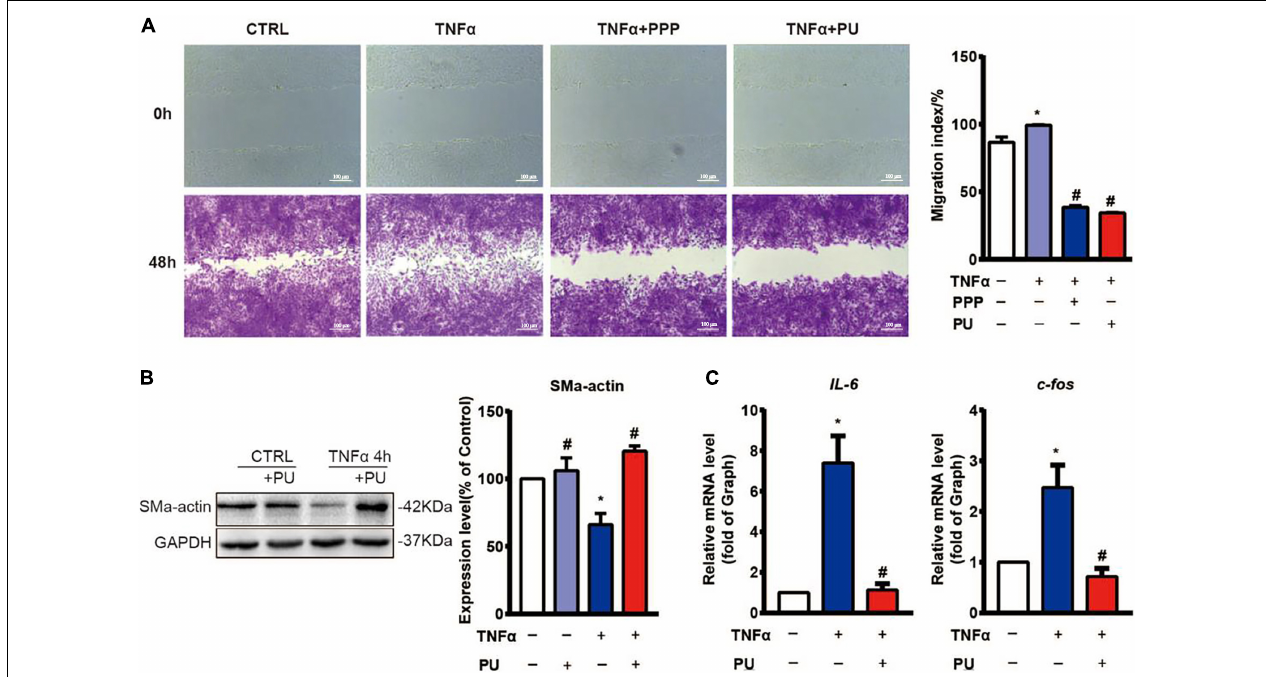
FIGURE 8 | PPP and PU inhibit migration, phenotypic modulation and inflammation in VSMCs induced by TNF- α . (A) The migration of VSMCs was detected by wound-healing assay (three independent experiments performed). (B) Western blot analysis and quantitative results of the effects of PU on α -SMA expression in VSMCs. Blot is a representative of four independent experiments. (C) Real time PCR results on the IL-6 and c-fos mRNA expressions. Experiments were repeated five times independently. * P < 0.05, vs. Vehicle, # P < 0.05 vs.